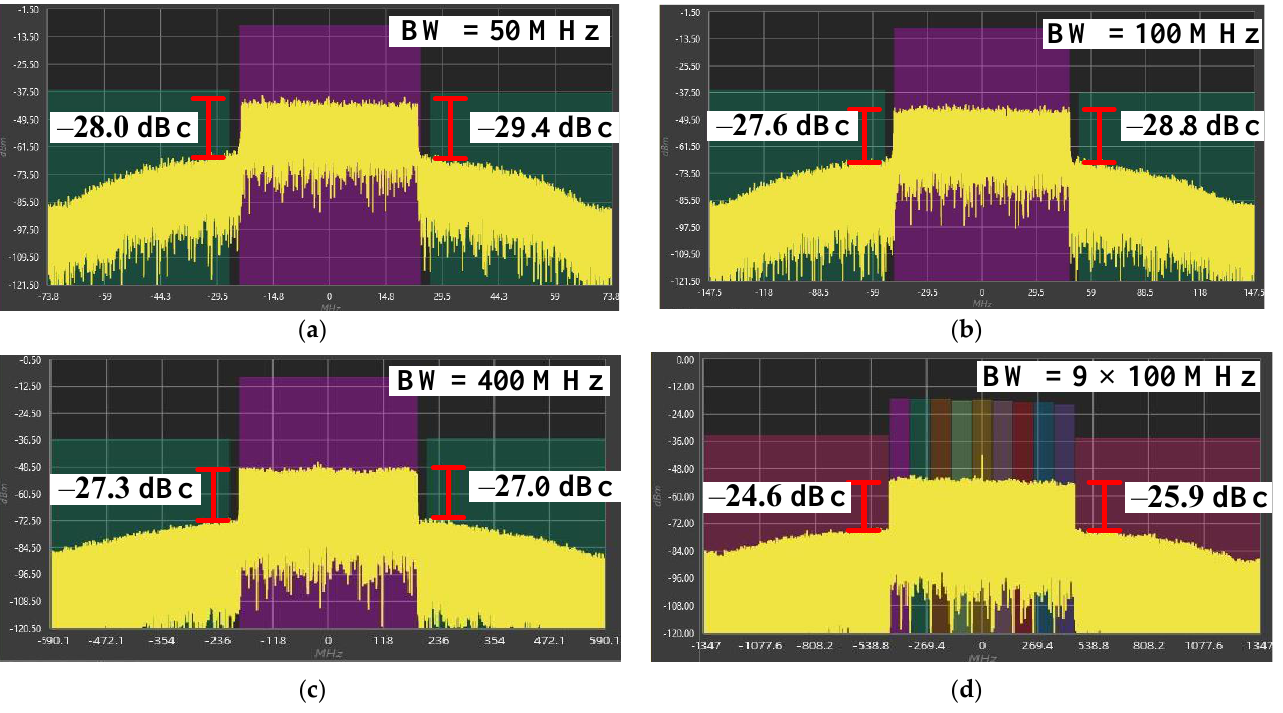
Figure 15. ACLR measurements of the broadband CMOS FD-SOI PA at 24 GHz using a 256-QAM- modulated 5G NR signal with PAPR = 8dB at a signal BW of ( a ) 50 MHz, ( b ) 100 MHz, ( c ) 400 MHz, and ( d ) 9 × 100 MHz.